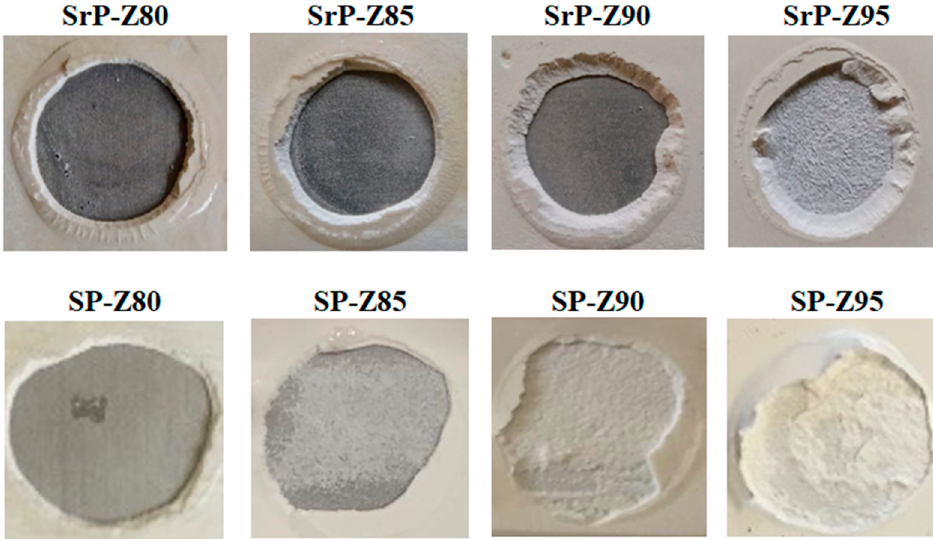
Figure 6. Pull-off fracture surface of the coating after pull-off test in S-PEEK and S-rPEEK. Conversely to S-PEEK coatings, which show a gradual evolution of the fracture type from totally adhesive to totally cohesive, in S-rPEEK coatings the fracture mechanism changes from adhesive to adhesive/cohesive only at very high zeolite content (from 90 wt.% to 95 wt.% zeolite). When the main fracture mechanism is adhesive (fracture propa- gates at the coating/metal substrate interface), as it is at low zeolite content, it means that the energy required to trigger a cohesive fracture in the bulk is greater than that required at the coating/substrate interface [44]. When the fracture mechanism is cohesive (fracture propagates into the composite coating bulk), as it is at high zeolite content, the energy required for the crack triggering at the filler/matrix interface is less than that required at the coating/substrate interface, indicating that the filler is not embedded suitably by the matrix. Particularly, for the SrP-Z95 coating, the fracture is a mixed cohesive/adhesive mode. It propagates at the coating/metal interface involving locally a bulk layer of the composite coating. This fracture mode is in contrast to what occurred in SP-Z95, where the pull-off fracture is dominated by a cohesive mode. In fact, the greater cohesive strength of the S-rPEEK coatings compared to the S-PEEK means that, at high zeolite content, a cohesive premature fracture does not occur; a mixed fracture occurs, indicating, indirectly, a greater interaction between filler and matrix in the former formulations. Figure 7 summarizes these finding in a histogram plot where the